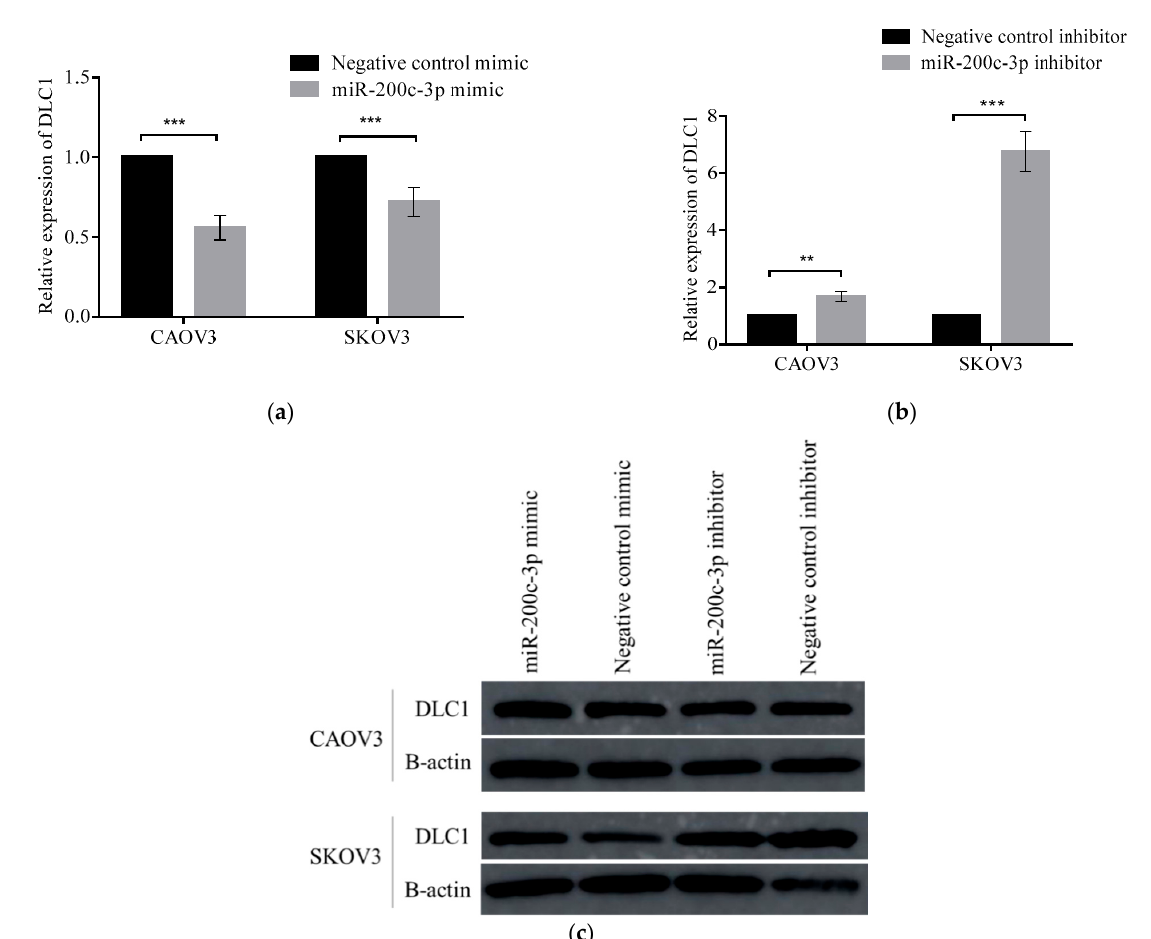
Figure 4. The expression of DLC1 in CAOV3 and SKOV3 cells. ( a ) After 48 h of miR-200c-3p mimic transfection, DLC1 mRNA levels were significantly reduced compared to negative control mimic. ( b ) Conversely, DLC1 mRNA expression levels increased with miR-200c-3p inhibitor, compared to negative controls. ( c ) Western blot assay showed no significant difference in DLC1 protein expression in both CAOV3 and SKOV3 cells. Significant values are indicated as follows: ** p < 0.01 and *** p < 0.001.